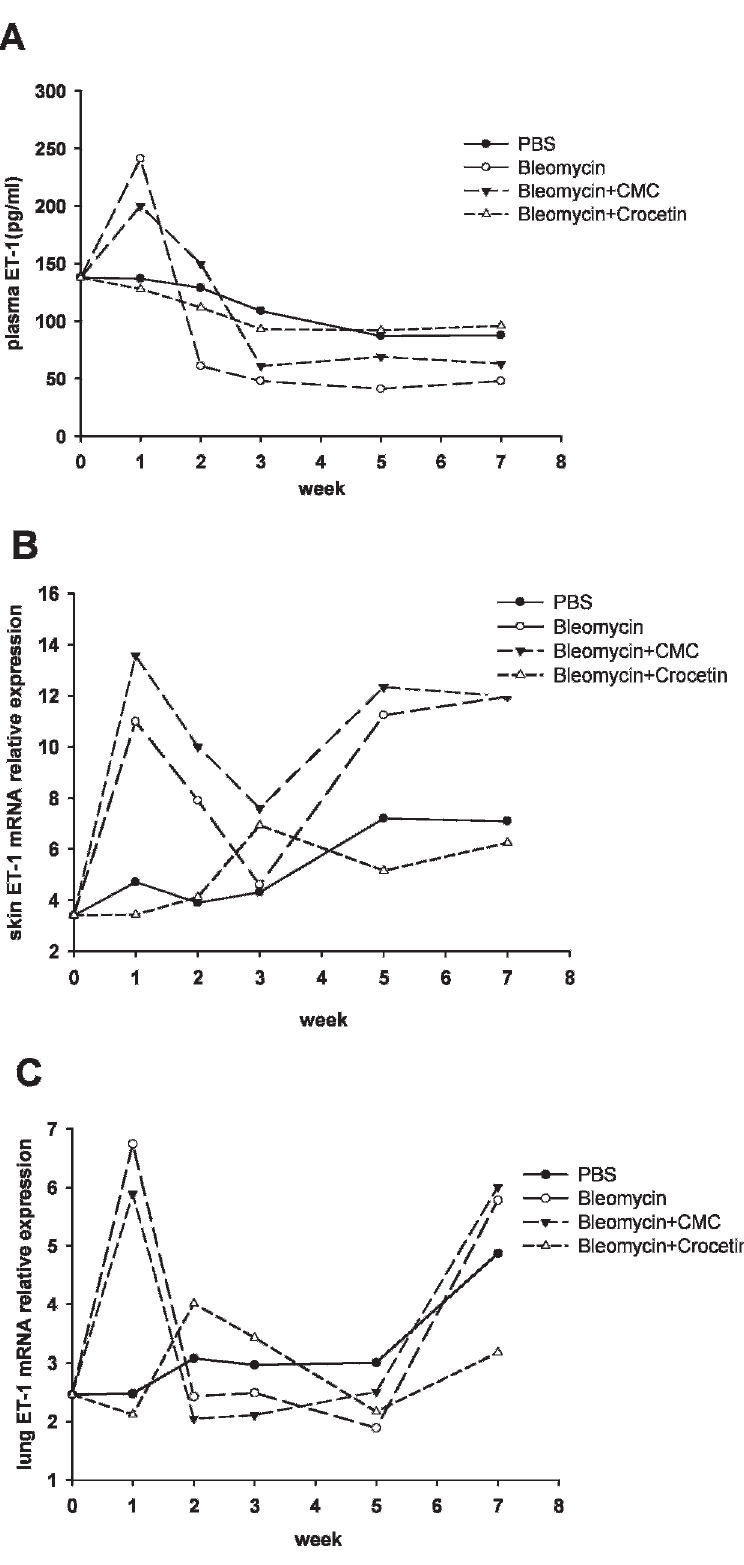
Figure 5 - Plasma, skin and lung ET-1 levels in mice. (A) Plasma ET-1 levels; (B) skin ET-1 mRNA levels; (C) lung ET-1 mRNA levels. Plasma ET-1 levels were detected using an ELISA. ET-1 mRNA expression was detected via a quantitative reverse transcription-polymerase chain reaction, and relative quantification was performed using the 2 - DD Ct